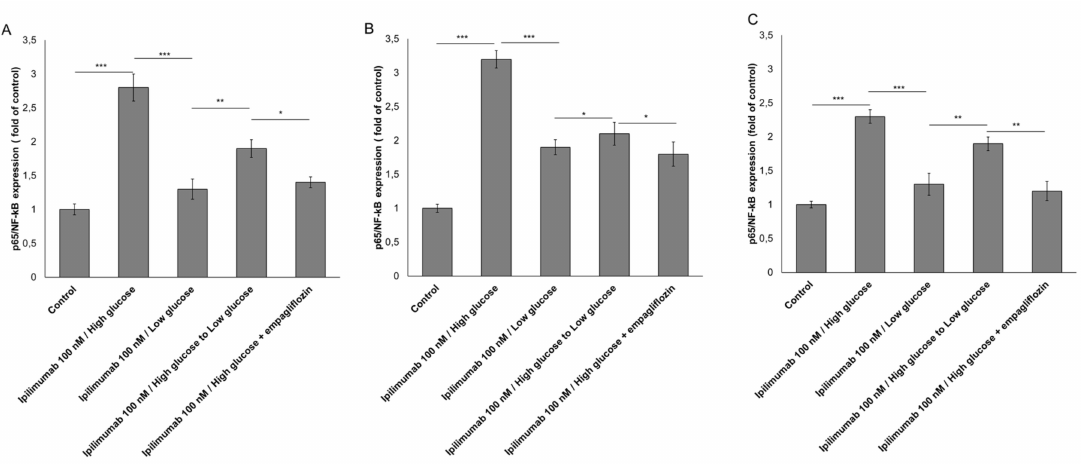
Figure 5. p65 / NF-kB expression(fold of control) expression in MCF-7 ( A ), MDA-MB-231 ( B ) and AC-16 ( C ) cells, treated with ipilimumab mAb in the presence of hPBMCs under di ff erent condition (high glucose; low glucose; high glucose + empagliflozin at 500 nM; shifting from a high glucose to low glucose). Untreated or treated cells with an unrelated control IgG (control) were used as negative controls. Error bars depict means ± SD ( n = 3). Statistical analysis was performed using paired t -test. *** p < 0.001. ** p < 0.01. * p <